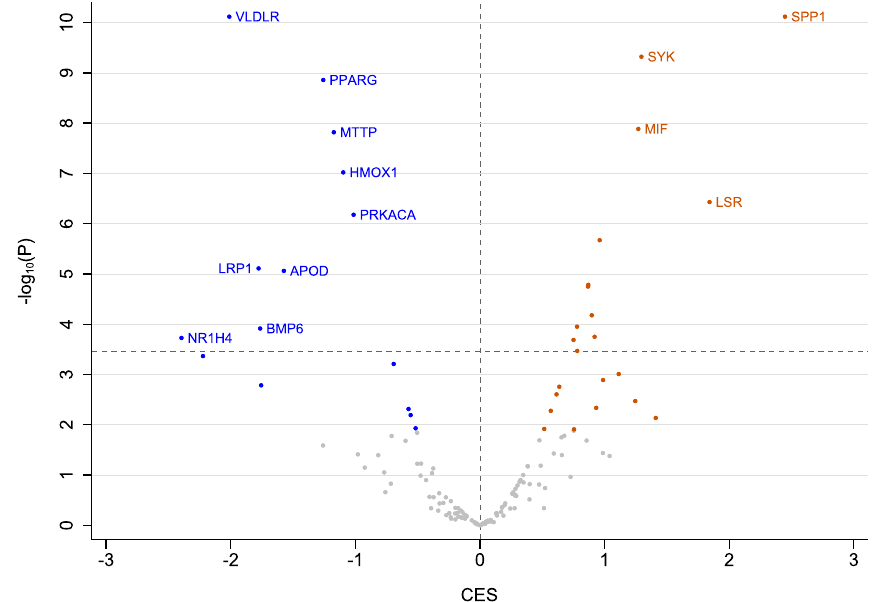
Figure 4. Gene expression differences in malignant versus benign ovarian tumor tissues. Differential expression analysis of 145 selected lipid-transport-related genes was conducted using RNA profiling data extracted from the NIH GEO archive. Results obtained from four independent sample sets (total N = 106 malignant, N = 51 benign) were meta-analyzed using NetworkAnalyst. Combined effect sizes (CES) and − log 10 P values are plotted. Genes satisfying FDR q < 0.05 are colored blue (downregulated) or orange (upregulated). Dashed horizontal line, Bonferroni-corrected threshold for statistical significance (− log 10 (0.05/145) =